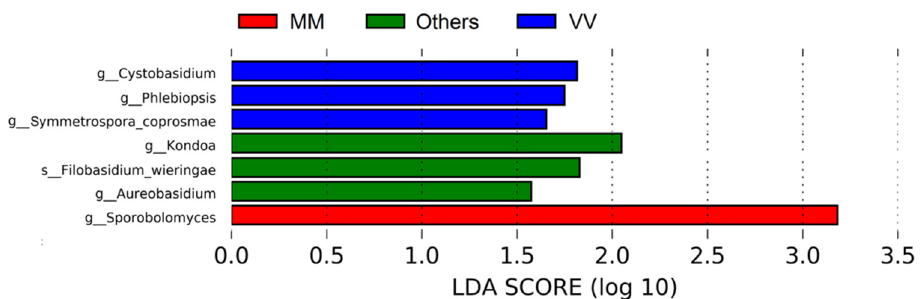
Figure 5. Linear Discriminant Analysis (LDA) scores computed for fungi features differentially abundant in parcels from MM, VV and Other groups.